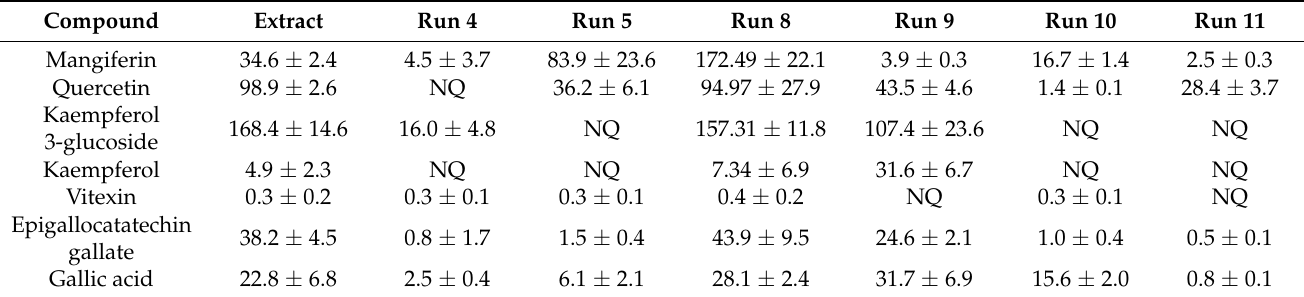
Table 6. Chemical composition of myrtle leaf extract and